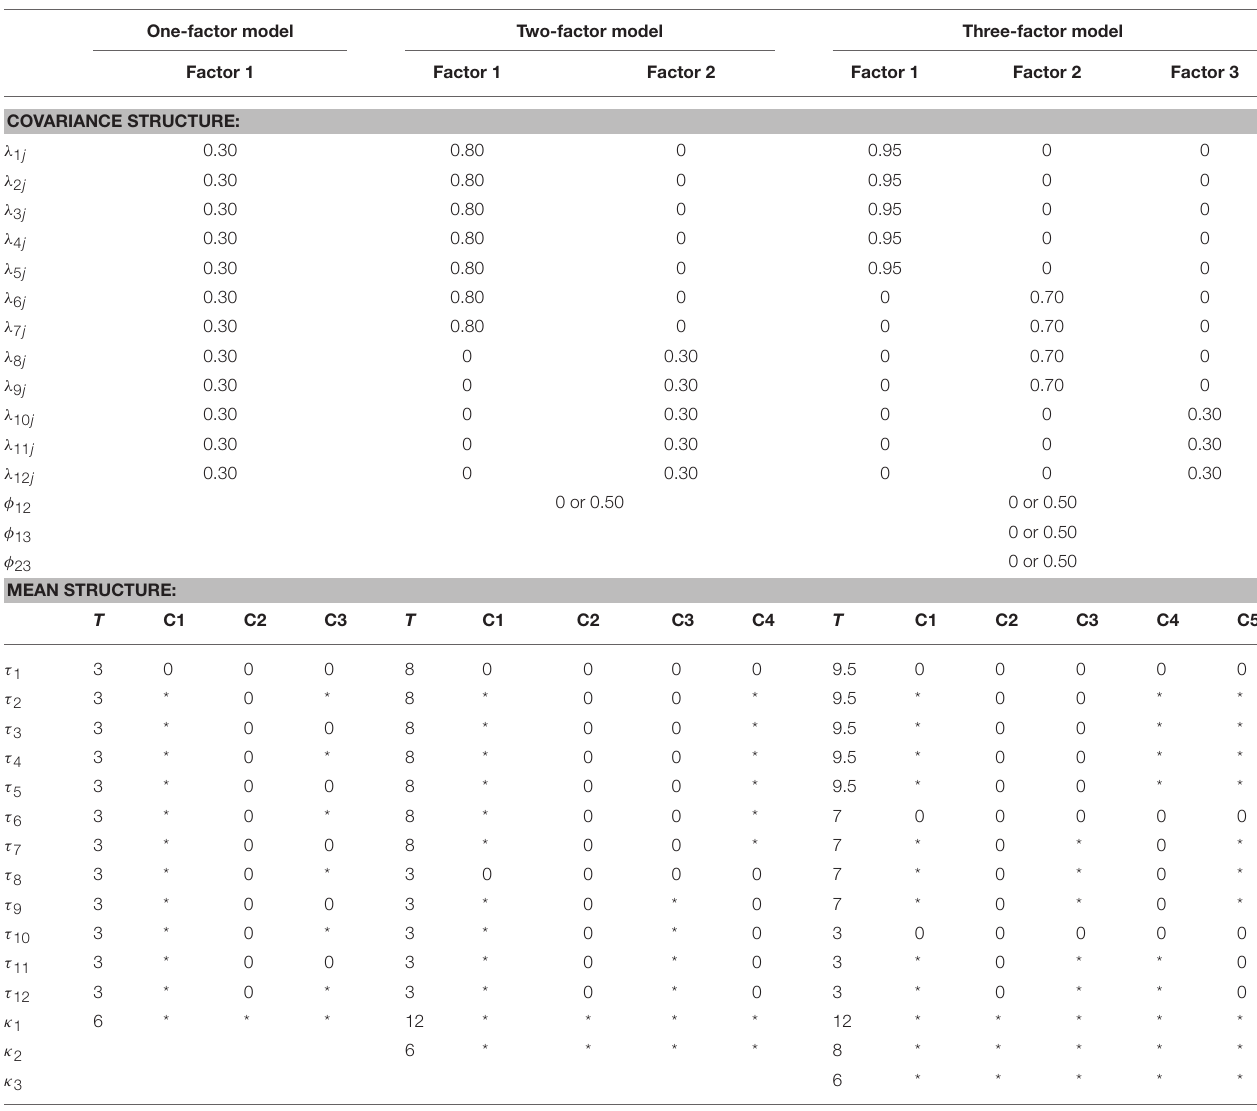
TABLE 1 | θ and ν true parameters of generating models. One-factor model Two-factor model Three-factor model Factor 1 Factor 1 Factor 2 Factor 1 Factor 2 Factor 3